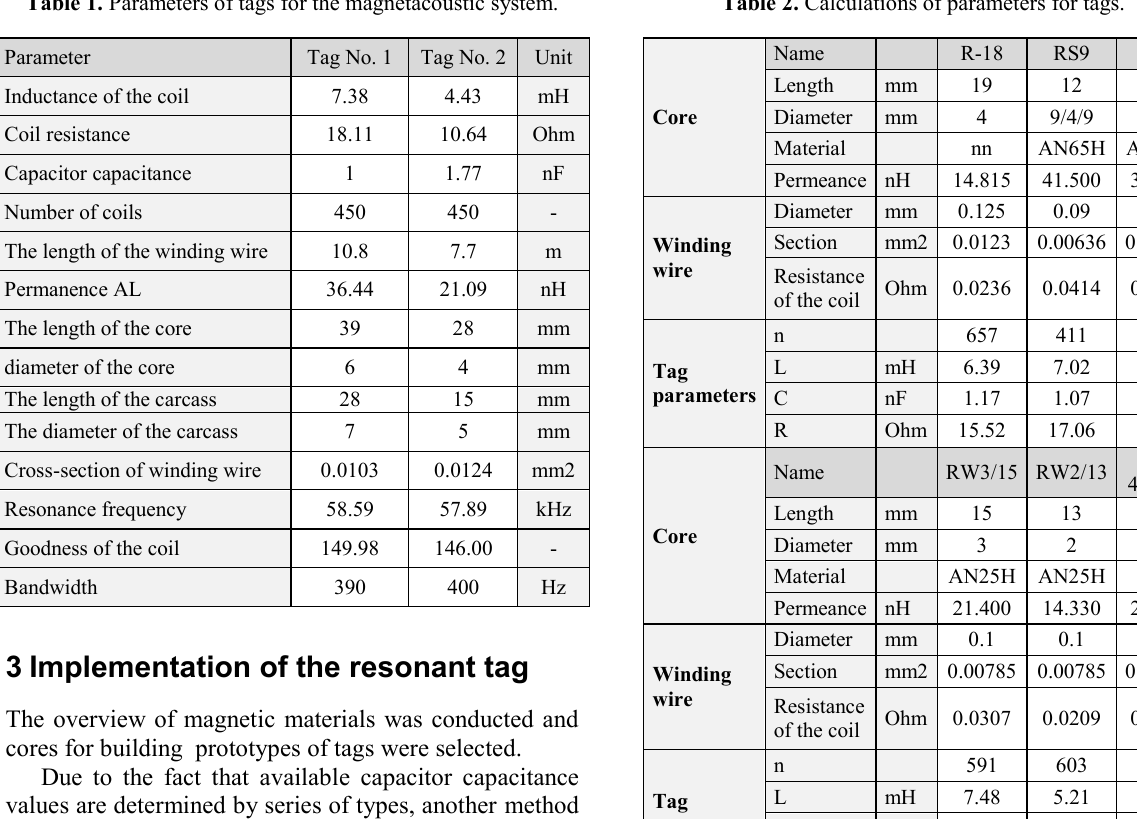
Table 2. Calculations of parameters for